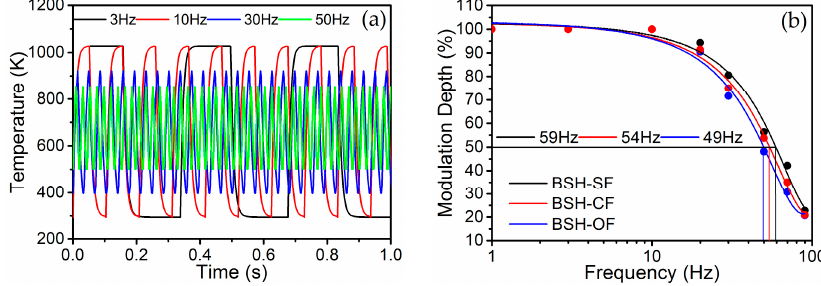
Figure 6. ( a ) Temperature response characteristics of BSH-OF emitter for typical 3, 10, 30, and 50 Hz of square wave voltages; ( b ) Comparison of frequency responses of BSH-SF, BSH-CF, and BSH-OF emitters.